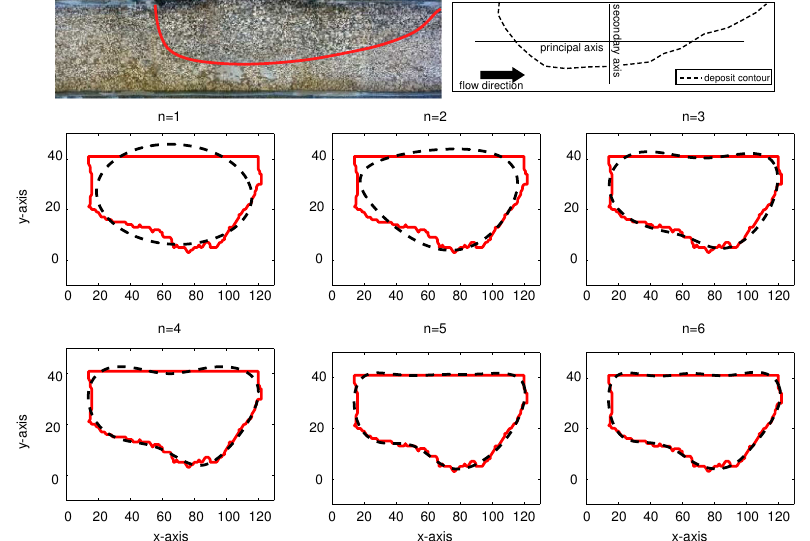
Figure 7. Application of the elliptic Fourier function for the description of the two-dimensional (2D) deposit-closed contour, by considering a progressively increasing number of harmonics ( n = 1–6). Data refers to test no. 10. The continuous red line is the 2D contour of the deposit corresponding to an elevation of 5.5 cm with respect to the channel bed. The dashed line represents the closed curve obtained by considering the first-n elliptic Fourier harmonic. The elliptic principal and secondary axes are indicated in the sketch.